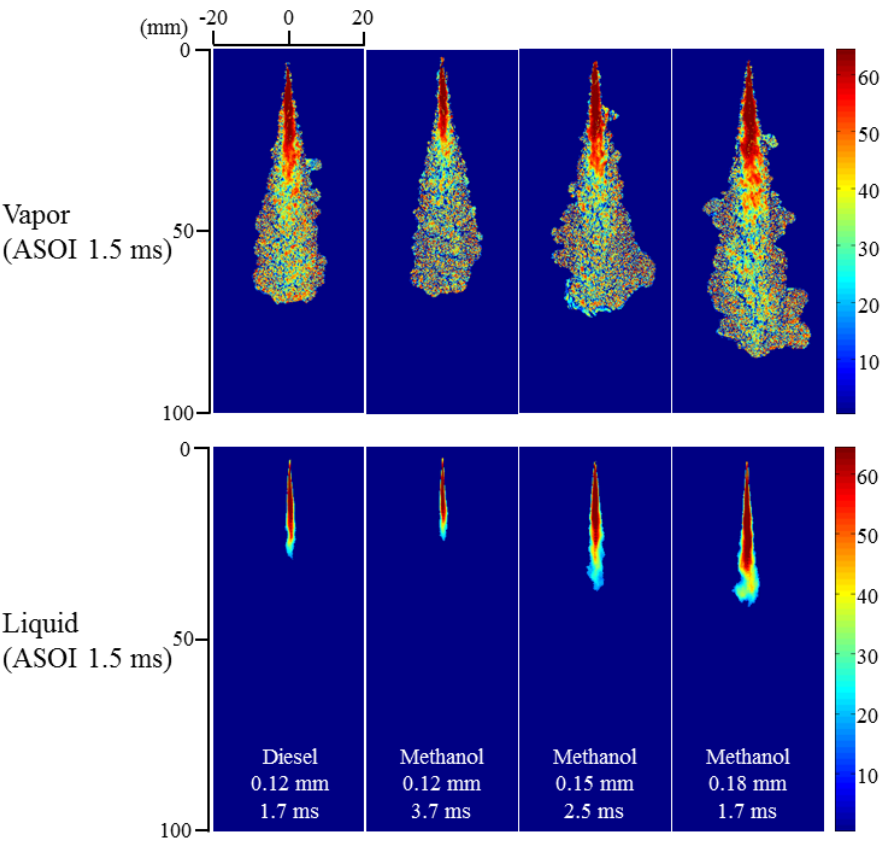
Figure 10. Comparison results of typical evaporating spray images under different strategies. The vapor phase spray tip penetration results are plotted in Figure 11a, and the absolute value of the subtraction result between diesel and methanol under different hole diameter conditions is also presented in the upper zone. With the increase in hole diameter, the rate of the methanol spray tip penetration increases by a lot, while the value at the end of the injection decreases from 97.2 mm to 90.2 mm because of the shortened injection duration. Moreover, even though the 0.12 mm hole diameter condition can achieve a similar increasing rate of penetration compared to that of diesel, the penetration is prolonged to 97.2 mm, which is much longer than the 71.2 mm value of the diesel spray at the end of the injection, because the injection duration is prolonged enough to achieve the same fuel energy injection. Other the other hand, it is noticeable that the spray tip penetration is longer than that of diesel during the whole injection duration under larger hole